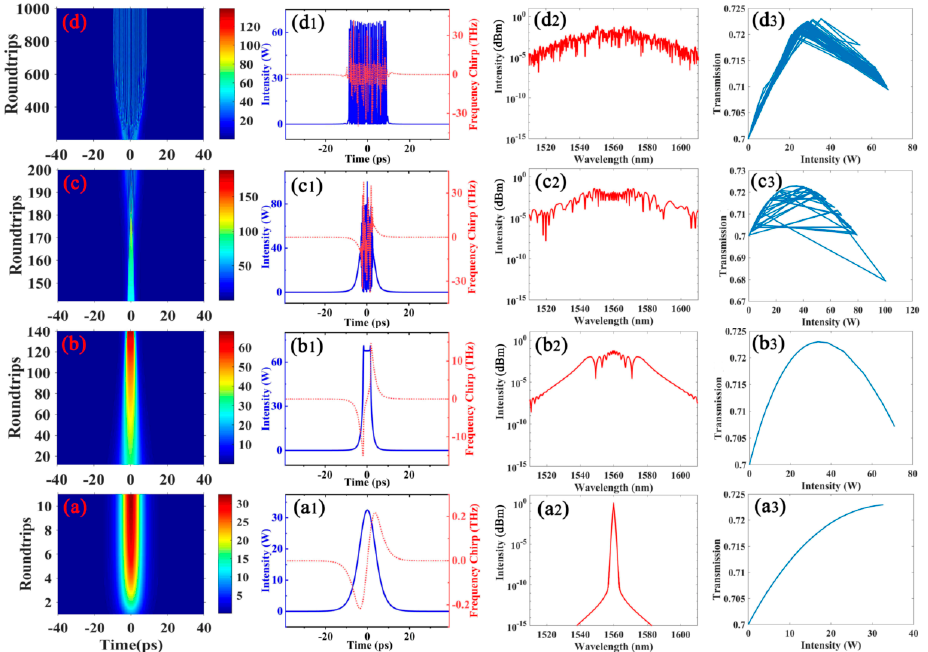
Figure 11. Numerical simulation of NLP formation process in different roundtrips with the assistance of reverse absorption coefficient at 0.0015 W − 1 . ( a )–( d ) Pulse shape, optical spectrum and SA transmittance curves of the typical four-stages NLP formation: pulse amplifier, peak power clamping, pulse instability, and NLP envelope stability; ( a1 )–( a3 ) the pulse amplifier stage; ( b1 )–( b3 ) the peak power clamping stage; ( c1 )–( c3 ) the pulse instability stage; ( d1 )–( d3 ) the NLP envelope stability stage. The NLP envelope characteristics are directly corresponding to the reverse absorption